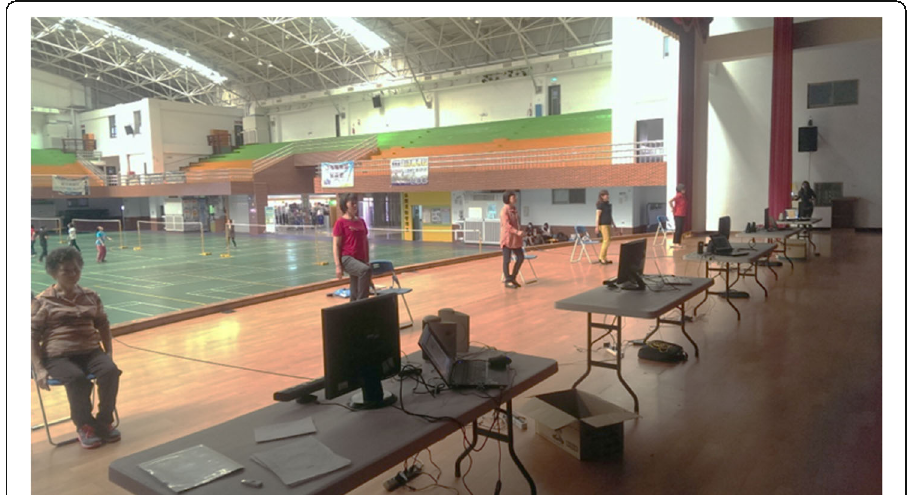
Fig. 10 Experimental environment